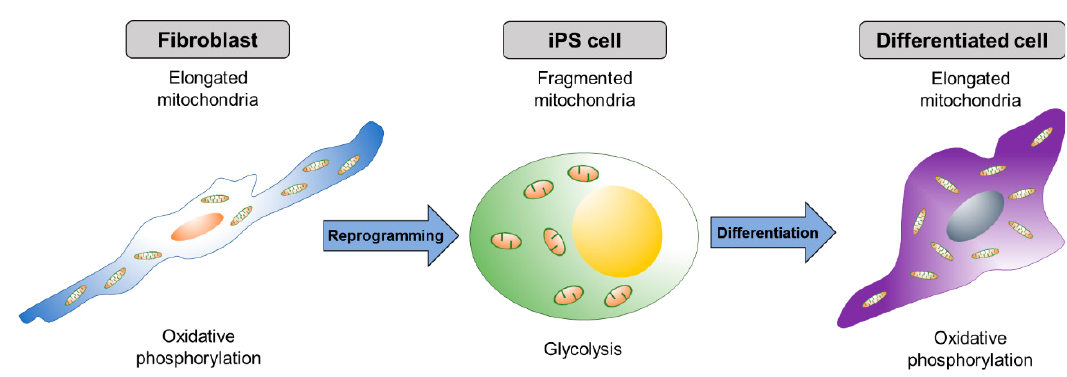
Figure 2. Dynamic change of mitochondrial shape during reprogramming and differentiation. Elongated mitochondria in differentiated cells become spherical shaped during the formation of iPSCs. As iPSCs differentiate, mitochondria resort back to the elongated shape.